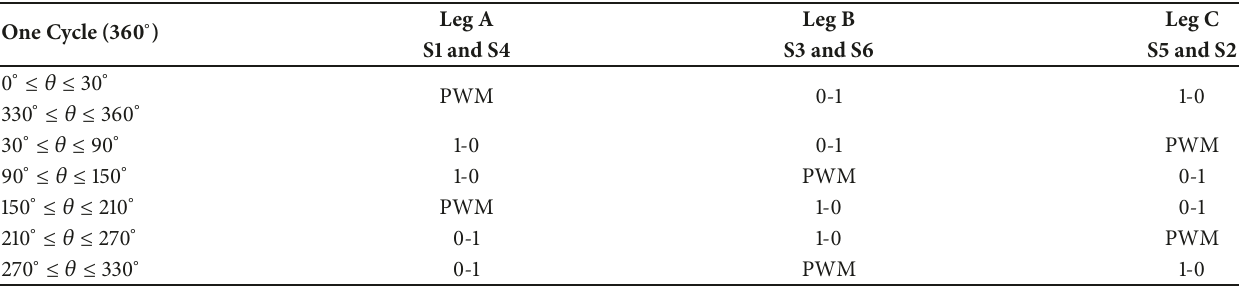
Table 2: Switching states of the proposed 120